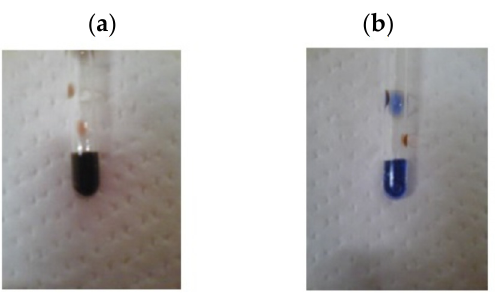
Figure 1. Solution with developing Belousov–Zhabotinsky (BZ) reaction at different moments separated by 120 s. Blue ( a ) and red ( b ) color indicates different stages of chemical oscillations corresponding to ferroin ( a ) and ferriin ( b ), respectively.